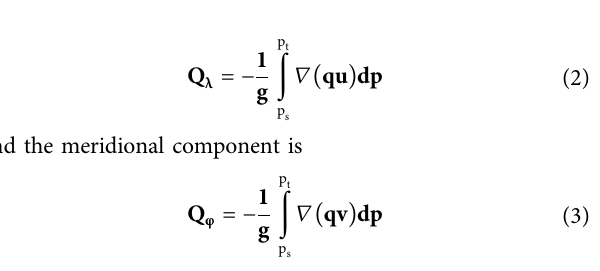
FIGURE 3 | Evolution of the anomalous sea level pressure (SLP) (shading; unit: hPa), 850-hPa winds (blue arrows; unit: m s − 1 ), vertically integrated water vapor transport (WVT) (vectors; unit: kg m − 1 s − 1 ), and WVT budget on (A,B) 11 – 13 November, (C,D) 14 – 16 November, and (E,F) 17 – 19 November 2020.